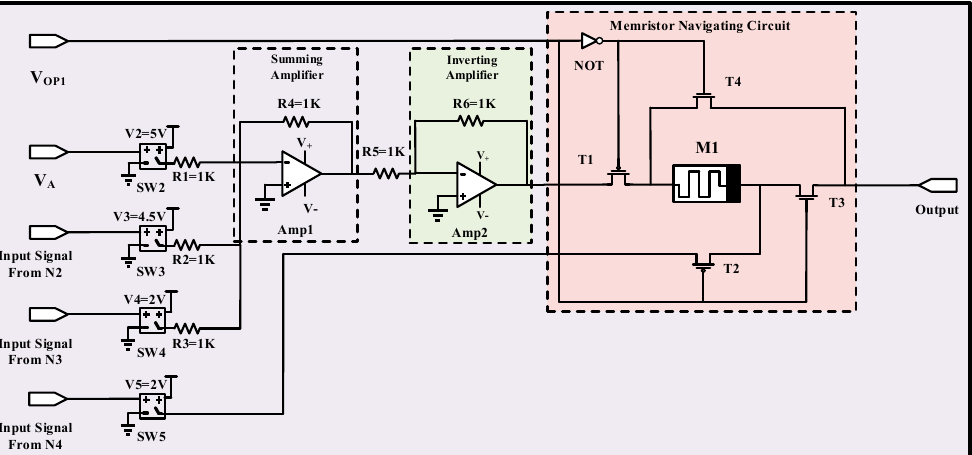
Figure 5. The circuit-level implementation of modeled Synapse 2 consisting of three input neurons (N2–N4).